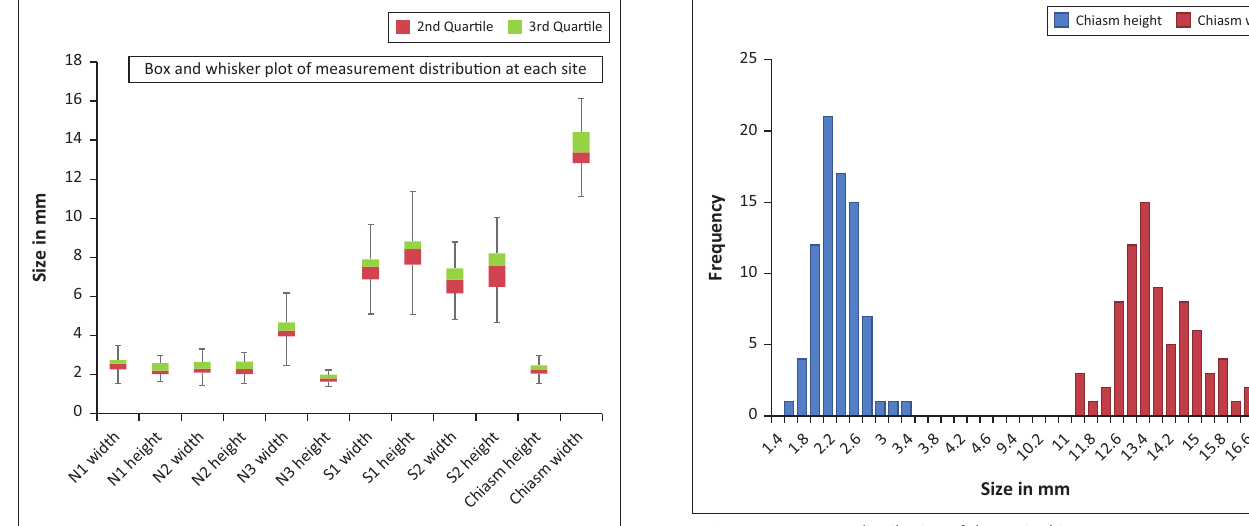
FIGURE 7: Frequency distribution of the optic chiasm.